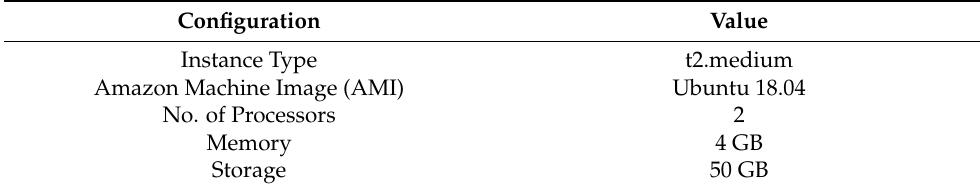
Table 3. System configuration of the cloud